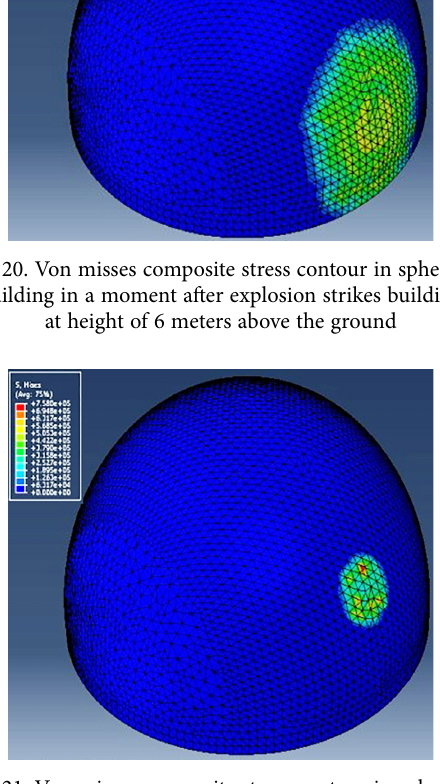
Fig. 21. Von misses composite stress contour in spherical building while explosion strikes building in 12 meters high from the ground